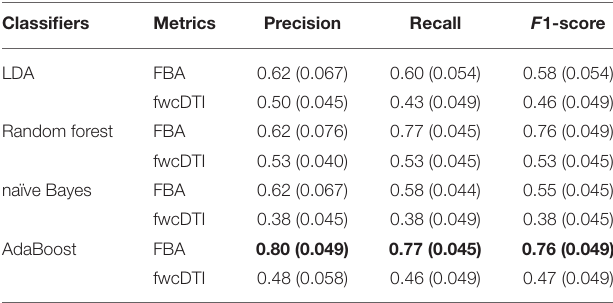
TABLE 3 | Precision, recall, and F1-scores for five different classifiers for FBA and fwcDTI metrics reported using five-fold cross-validation in HIV + subjects